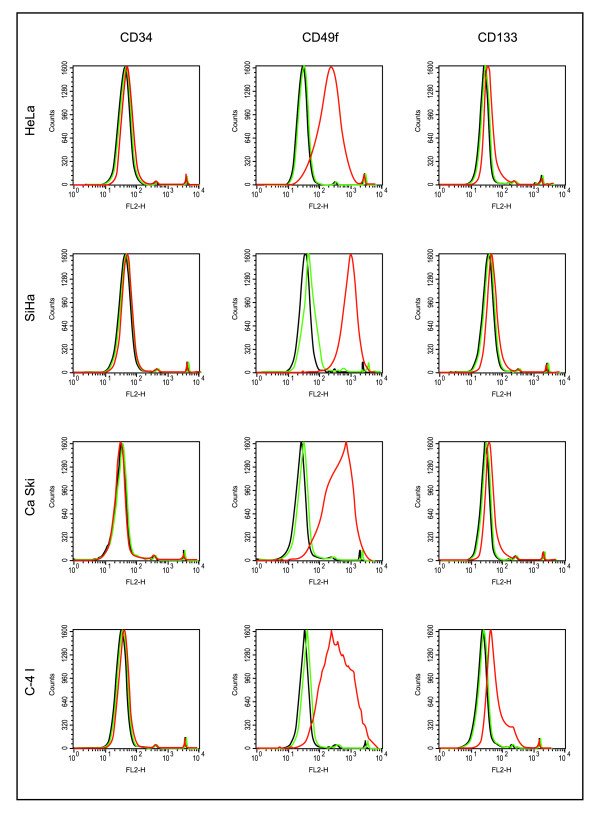
Immune phenotype analysis of cervical tumor sphere-forming cells. Sphere-forming cells and monolayer cells were stained with CD34, CD49f, and CD133 conjugated primary antibodies and subjected to flow cytometry. Red line corresponds to sphere-forming cells, green line to monolayer cells, and black line to isotype control